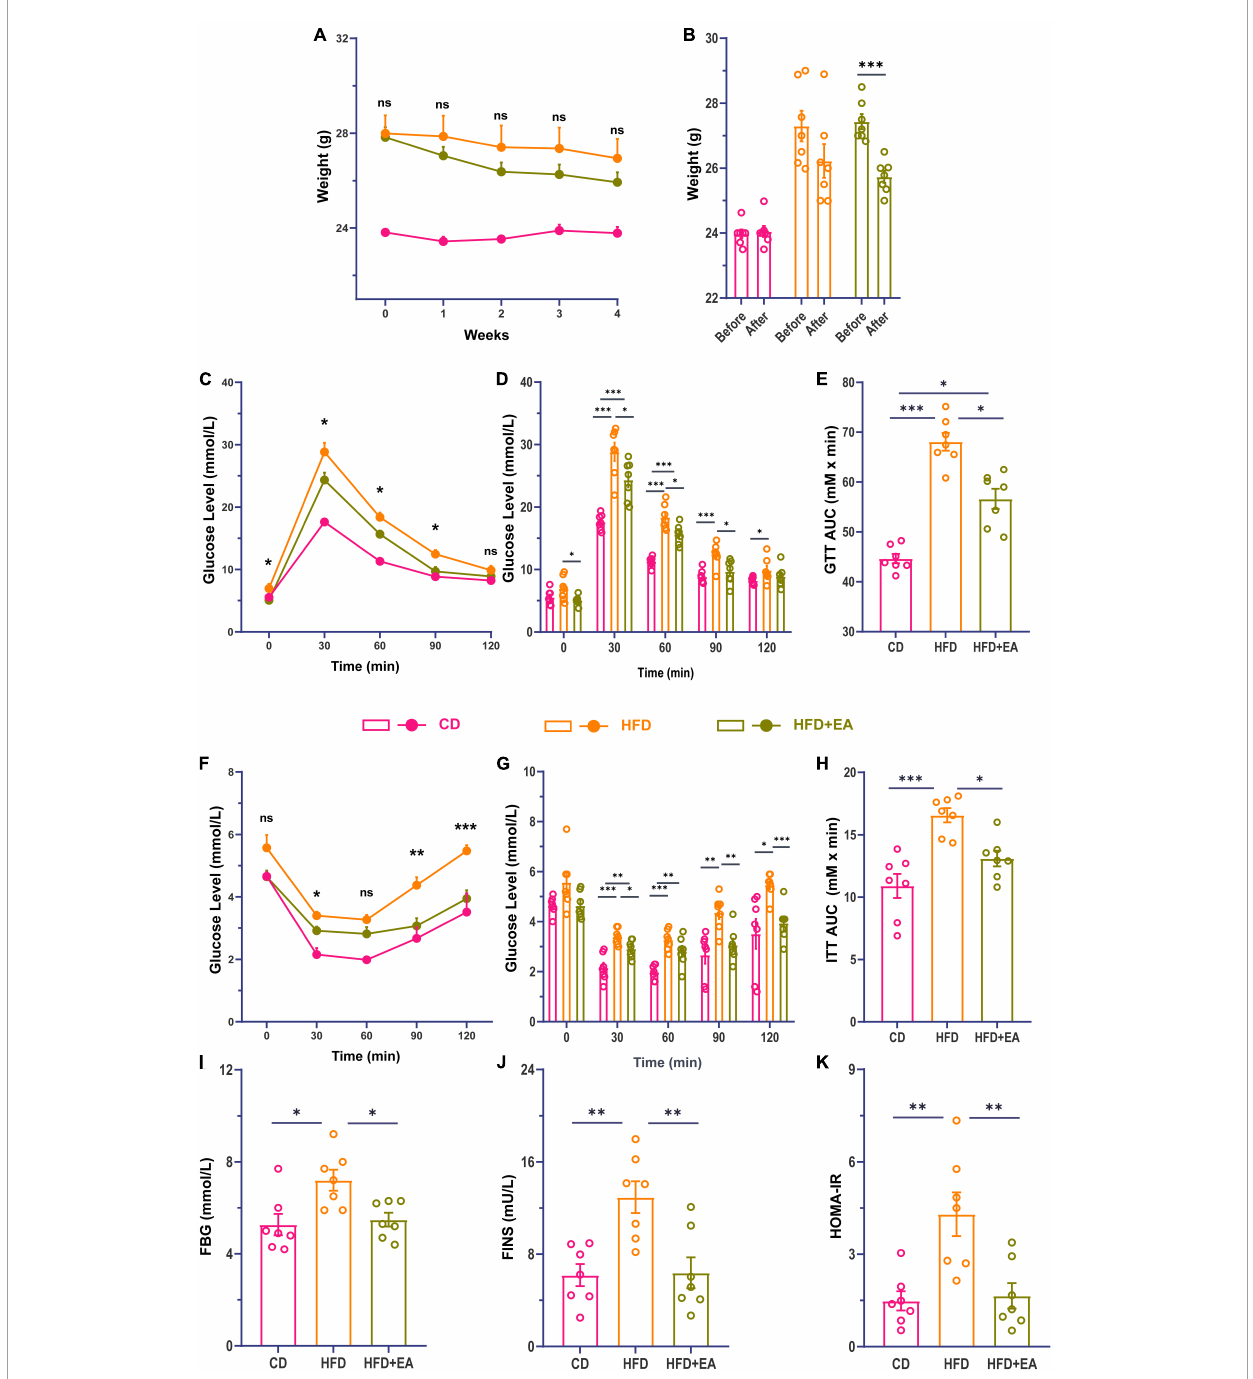
FIGURE1 EA ameliorate high-fat diet-induced insulin resistance in mice. (A) Comparison of body weight changes during EA. (B) Comparison of body weight changes before and after EA. (C) Line chart of blood glucose change during glucose tolerance test in mice 4 weeks after EA. (D) Histogram of blood glucose change during glucose tolerance test in mice 4 weeks after EA. (E) Area under the glucose tolerance curve. (F) Line chart of blood glucose change during insulin tolerance test in mice 4 weeks after EA. (G) Histogram of blood glucose changes during insulin tolerance test in mice 4 weeks after EA. (H) Area under the insulin tolerance curve. (I) Fasting blood glucose of mice after EA. (J) Fasting serum insulin concentration of mice after EA. (K) Insulin resistance index of mice after EA. CD: control group. HFD: high-fat diet group. HFD + EA: model + electroacupuncture group. ns P > 0.05; ∗ P < 0.05; ∗∗ P < 0.01; ∗∗∗ P < 0.001 (one-way analysis of variance with post hoc Bonferroni correction or Tamhane